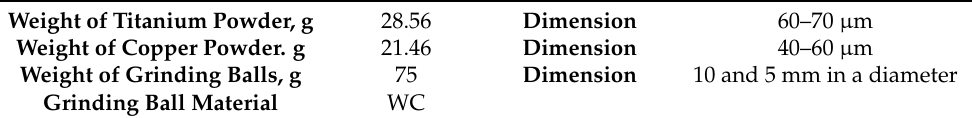
Table 1. Contents of mixing beakers.